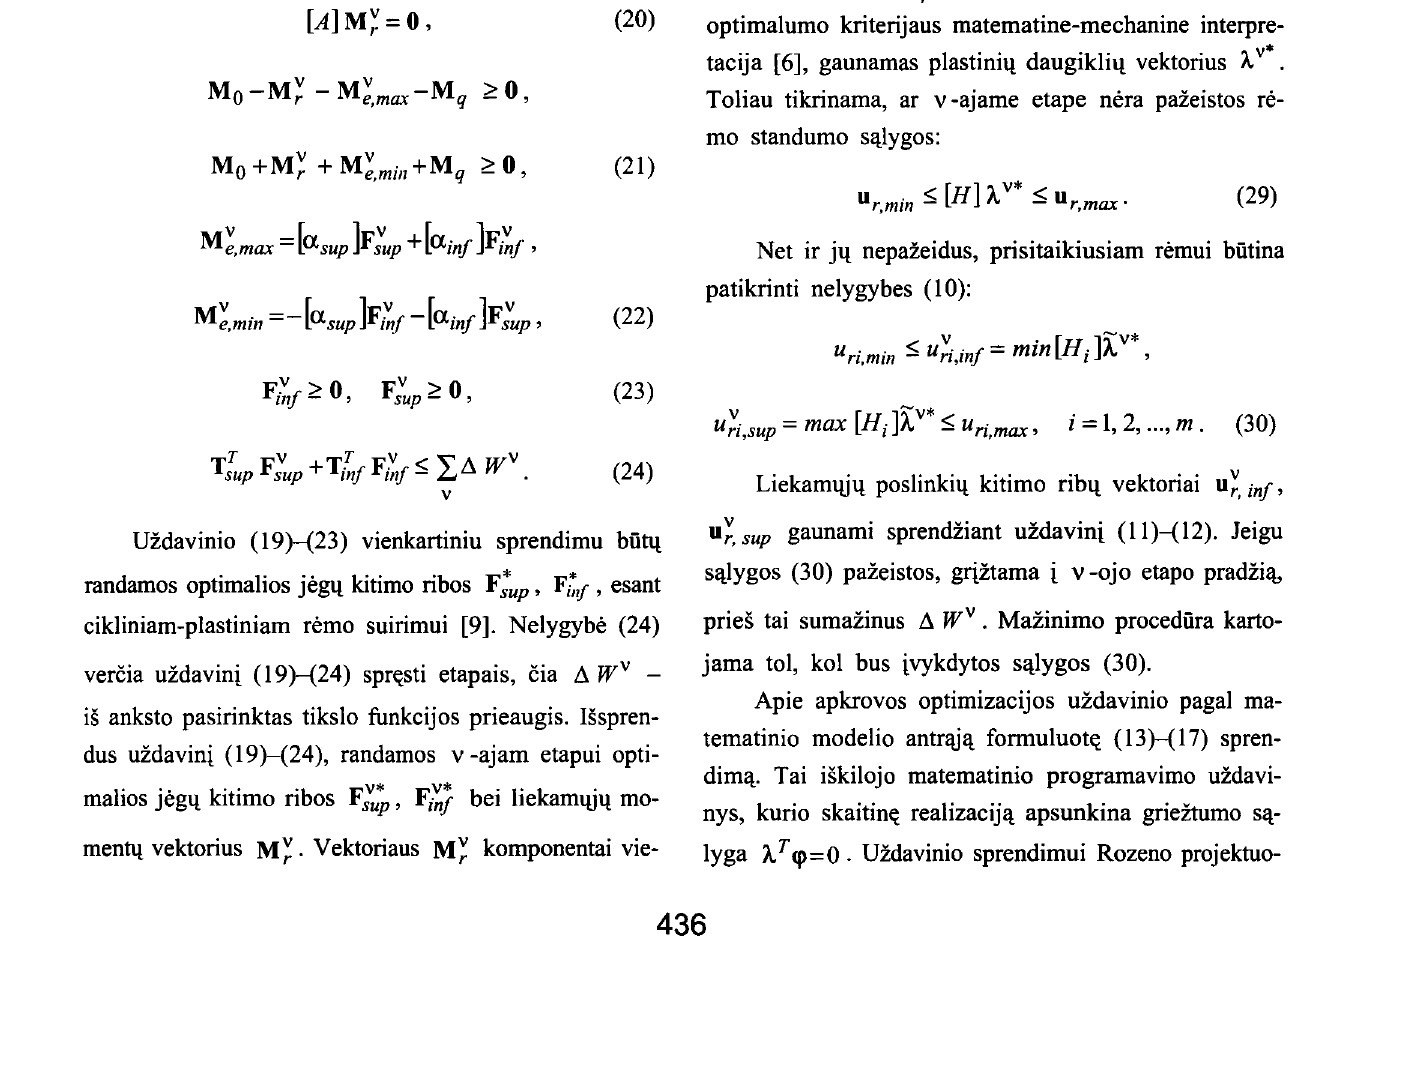
Uzdavinio (19}--{23) vienkartiniu sprendimu biitq randamos optimalios jegq kitimo ribos F;up , F;:if , esant cikliniam-plastiniam remo suirimui [9]. Nelygybe (24) vercia uzdavini (19}--{24) sprC(sti etapais, cia L1 wv - is anksto pasirinktas tikslo funkcijos prieaugis. ISspren dus uzdavini (19)-(24), randamos v -ajam etapui opti- malios jegq kitimo ribos Fiu~, F;';J bei liekam4.iq mo- mentq vektorius M~. Vektoriaus M~ komponentai